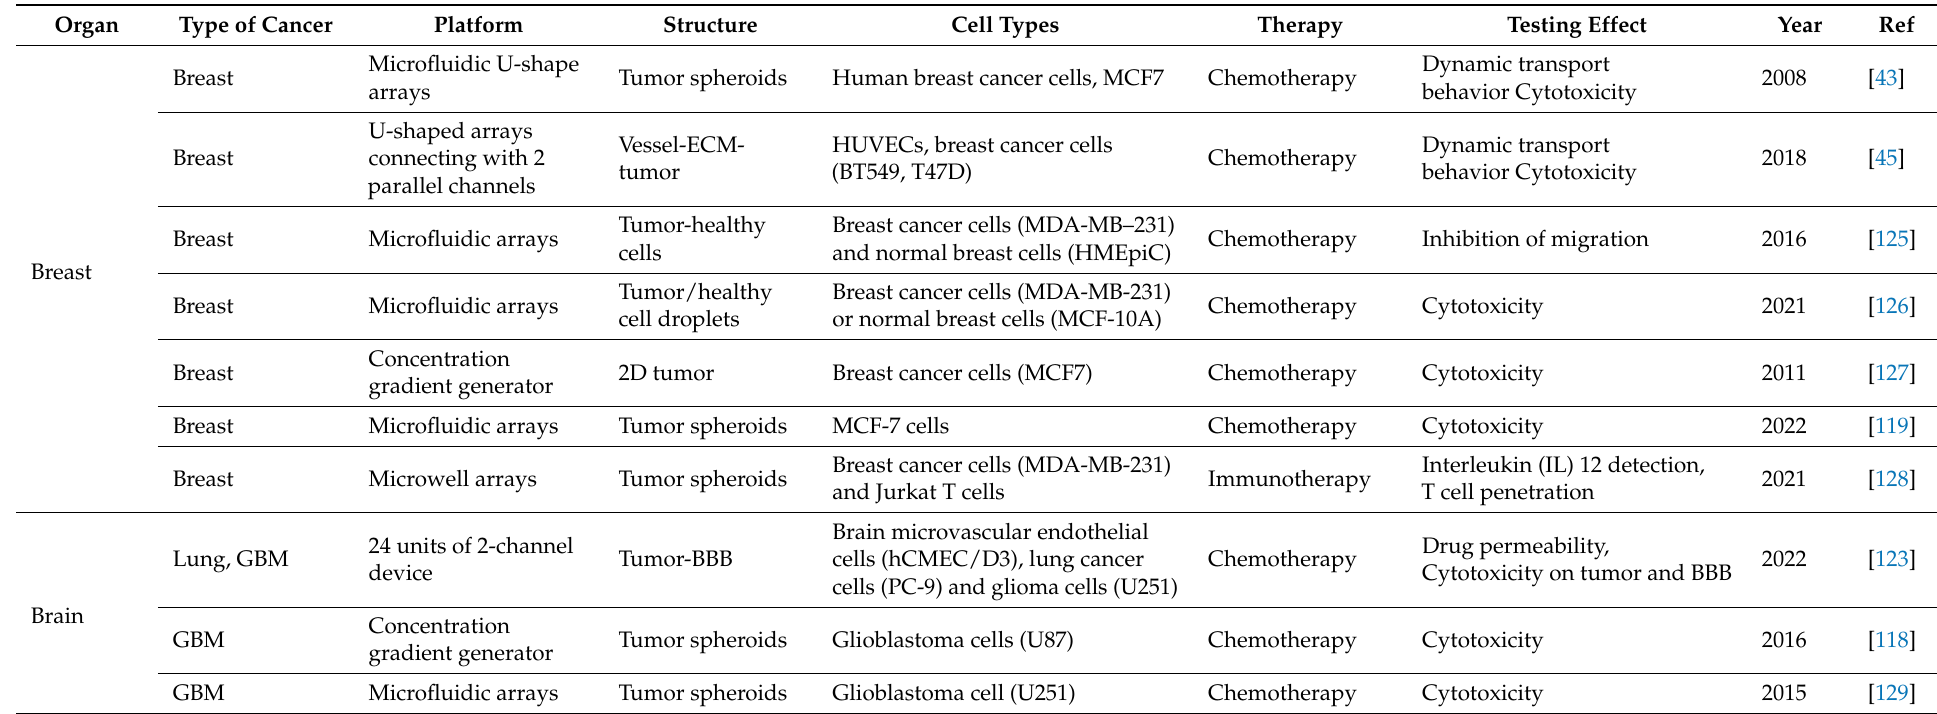
Table 1. High throughput platforms for anticancer drug